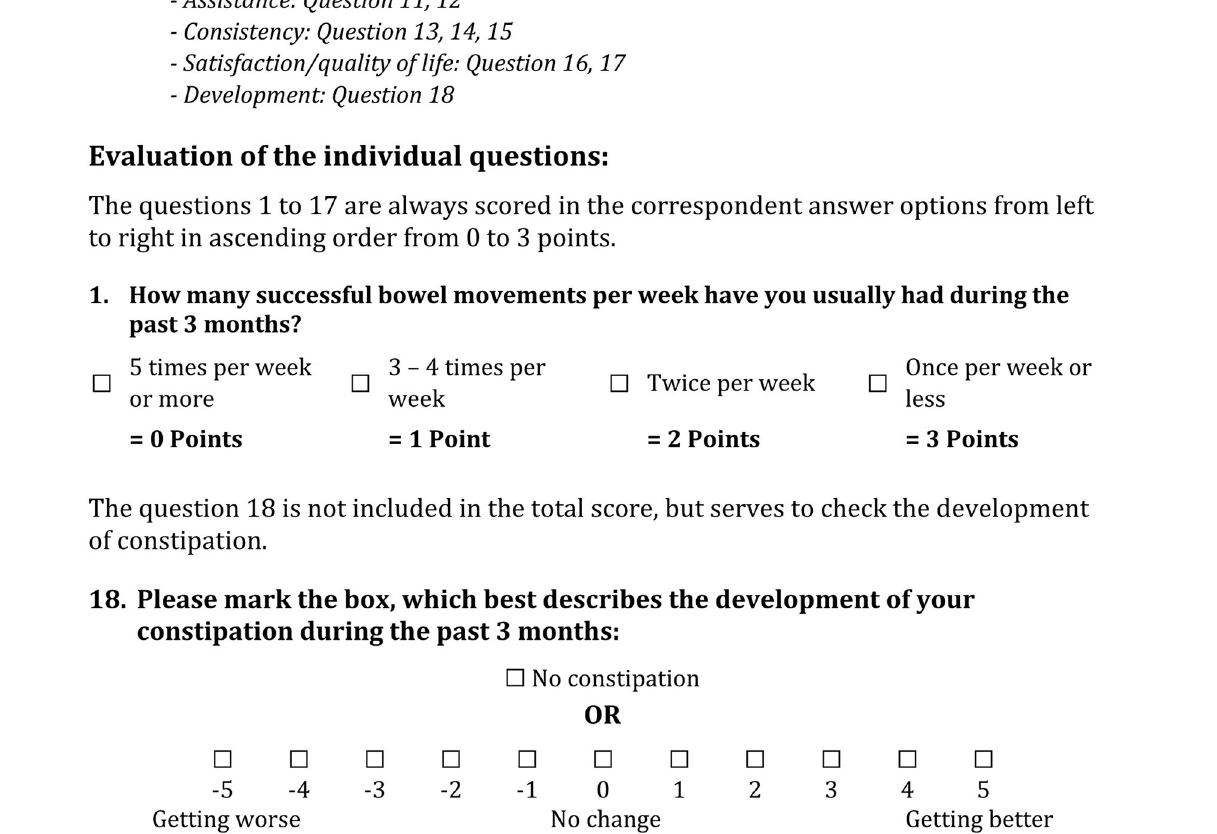
FIGURE4 Instructions for administration and evaluation of the Gut Dysmotility Questionnaire (GDQ).